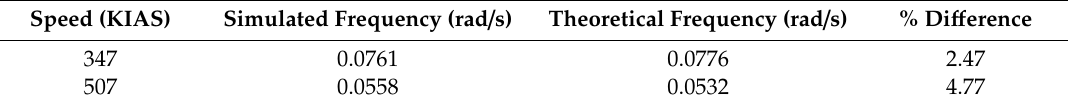
Table 6. Comparative results for the phugoid